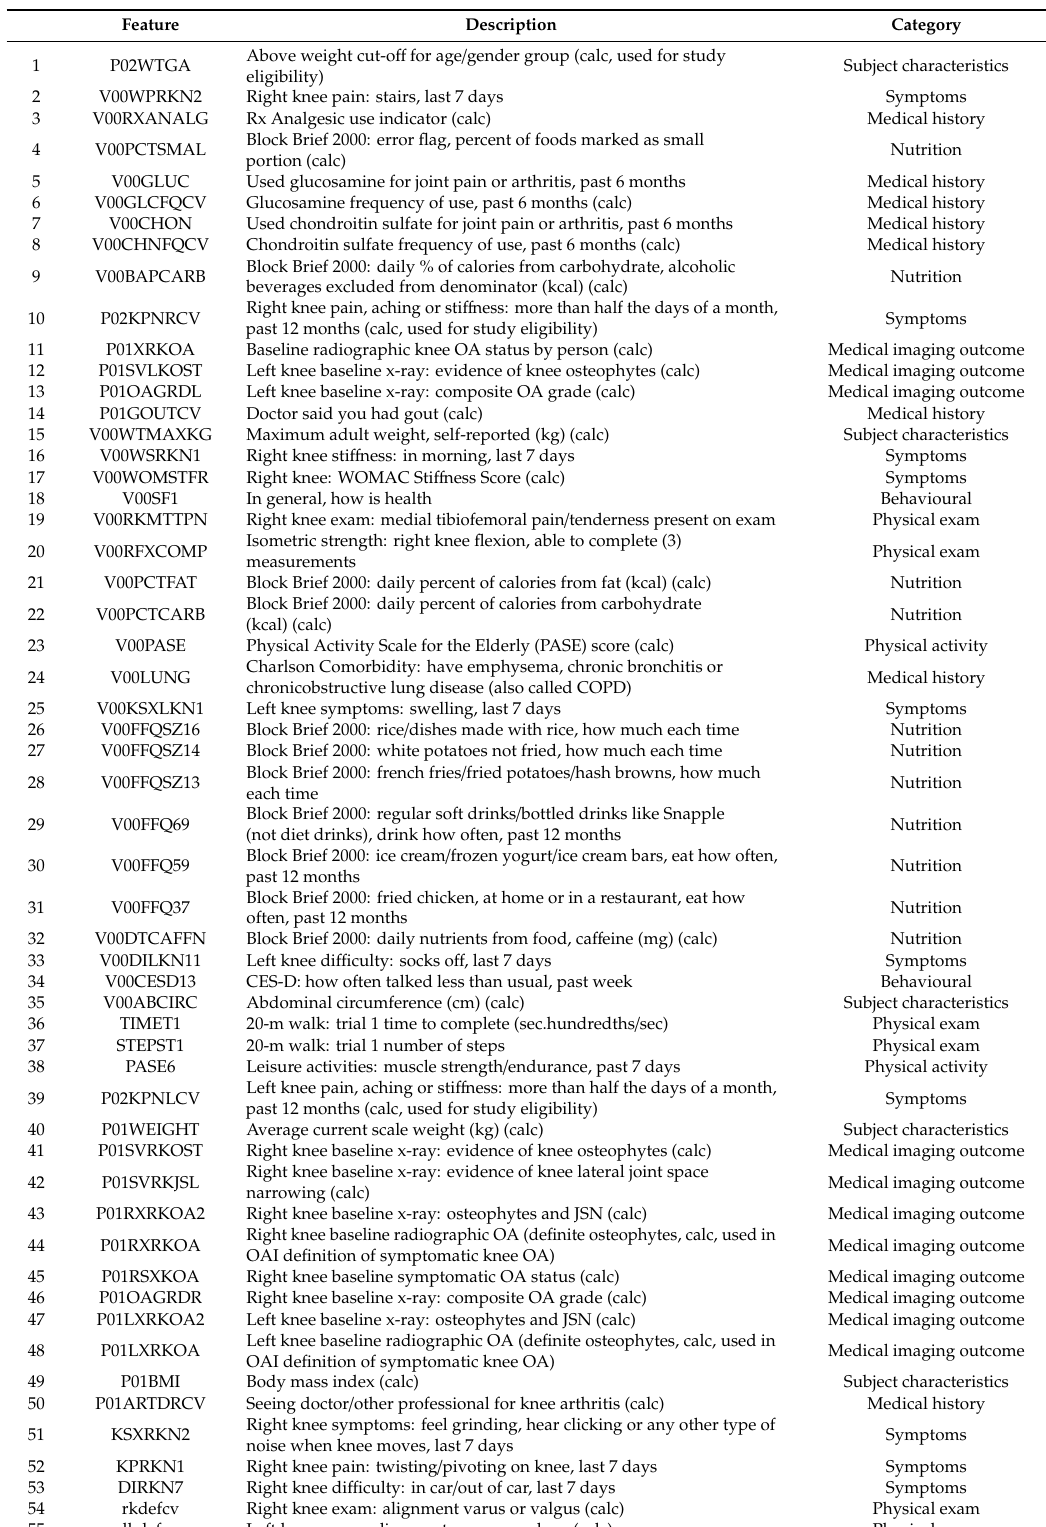
TableA1. SelectedfeaturesthatledtotheoverallbestKneeOsteoarthritis(KOA)predictionperformance in our